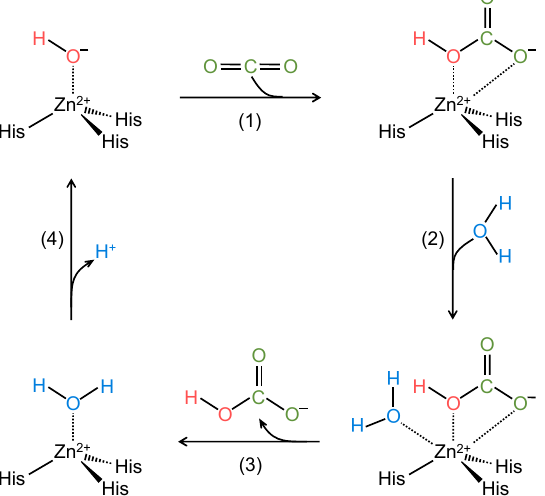
Figure 2. Schematics of the catalytic mechanism of action of α -CAs. In step #1, CO 2 (green-colored) reacts with a zinc-bound hydroxyl (OH − , red-colored), generating a coordinated HCO 3 − . In step #2, H 2 O (blue-colored) binds to zinc (Zn 2+ ). In step #3, HCO 3 − dissociates from Zn 2+ , thereby leading to the catalytically inactive form of the enzyme. In step #4, release of a H + ion from the Zn 2+ -bound H 2 O molecule regenerates the Zn 2+ -bound OH − group, thereby restoring the catalytic active form of the enzyme. His = histidine